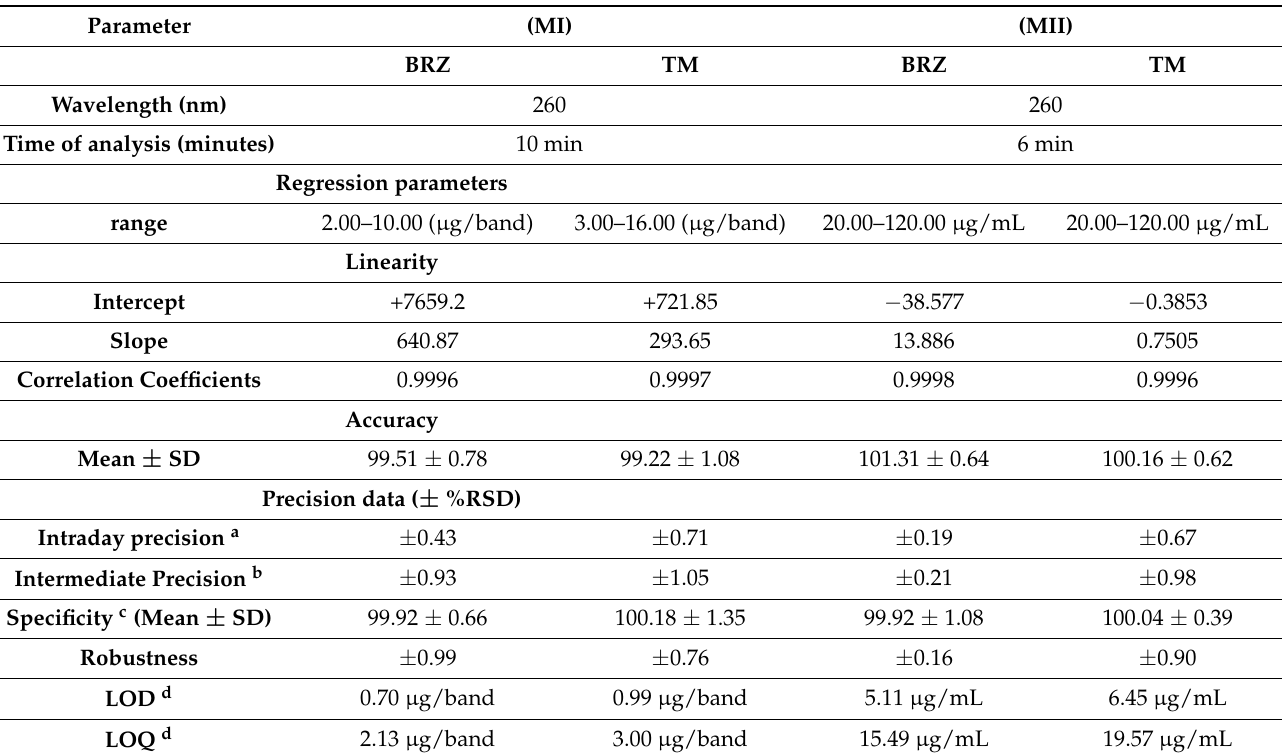
Table 1. Items for the Validation for TLC-densitometric (MI) and RP-HPLC (MII) methods for the analysis of BRZ and